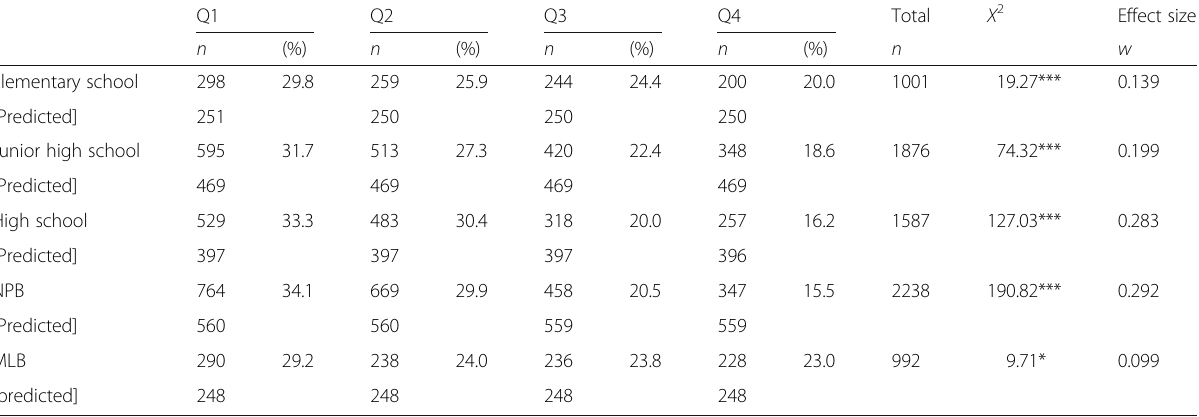
Table 1 Distribution of all players divided into quartiles in each